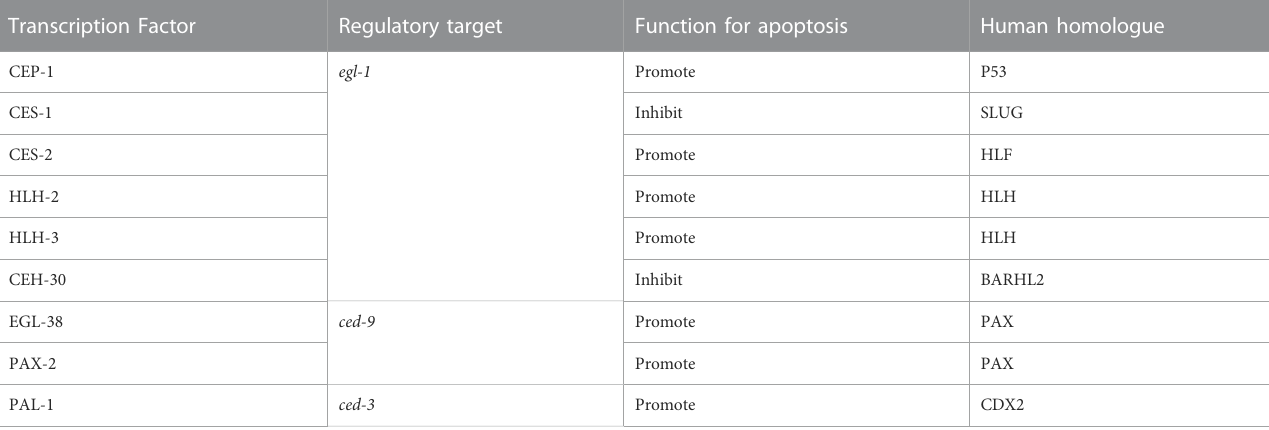
TABLE 1 The homologs of transcription factors regulating apoptosis in C. elegans